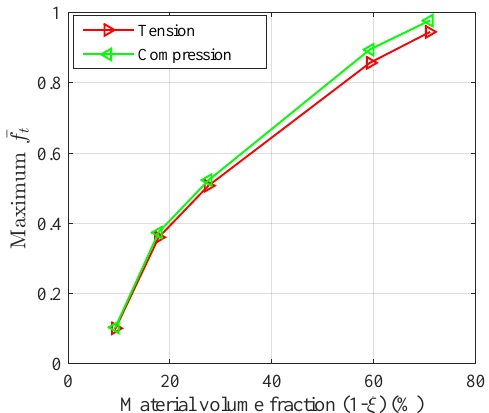
Figure 9. The relation between maximum martensitic volume fraction versus the material volume fraction when the absolute value of strain is up to 10%.